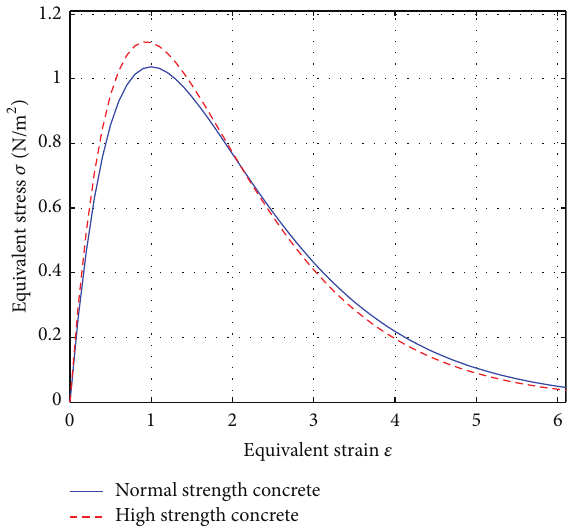
Figure 8: Constitutive relation of concrete with different strength based on approximate